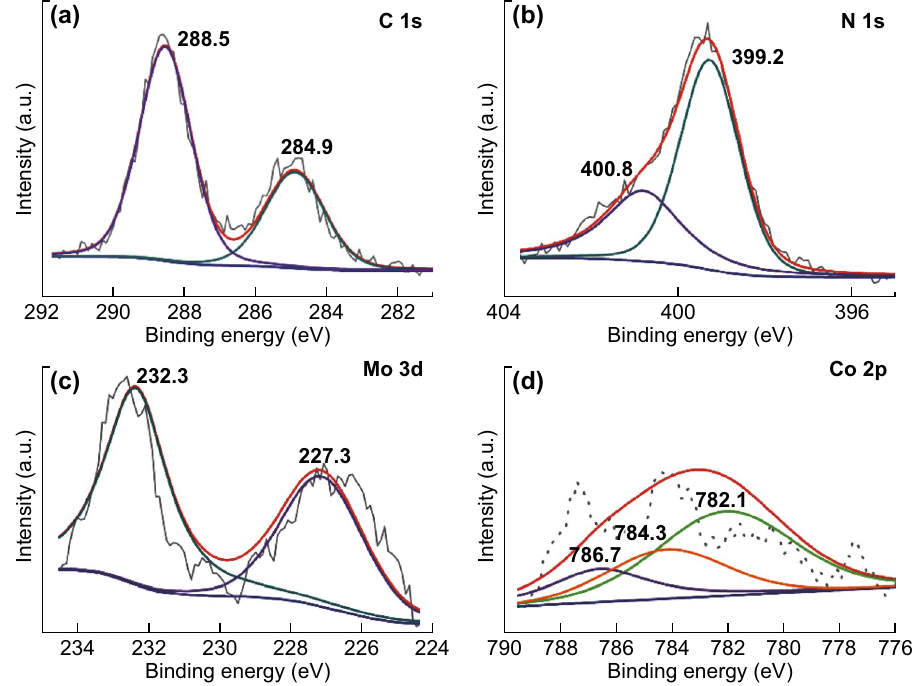
Fig. 5 XPS spectra of a C1s, b N1s, c Mo3d, and d Co2p for